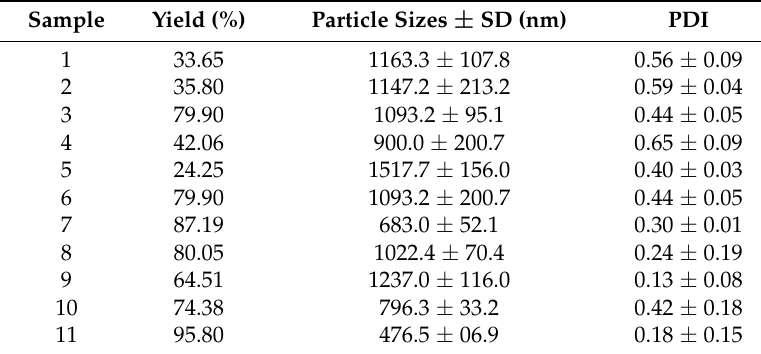
Table 3. Particle sizes and yield of OMC/SiO 2